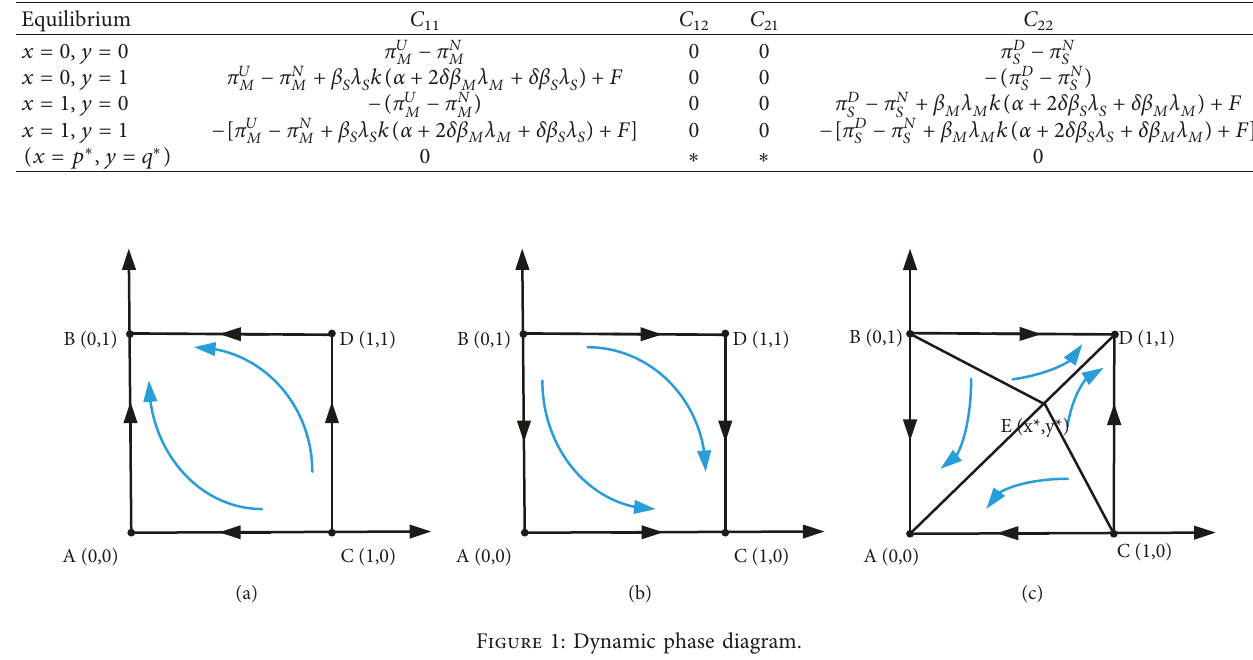
C C C at local equilibrium. 11 12 21 22